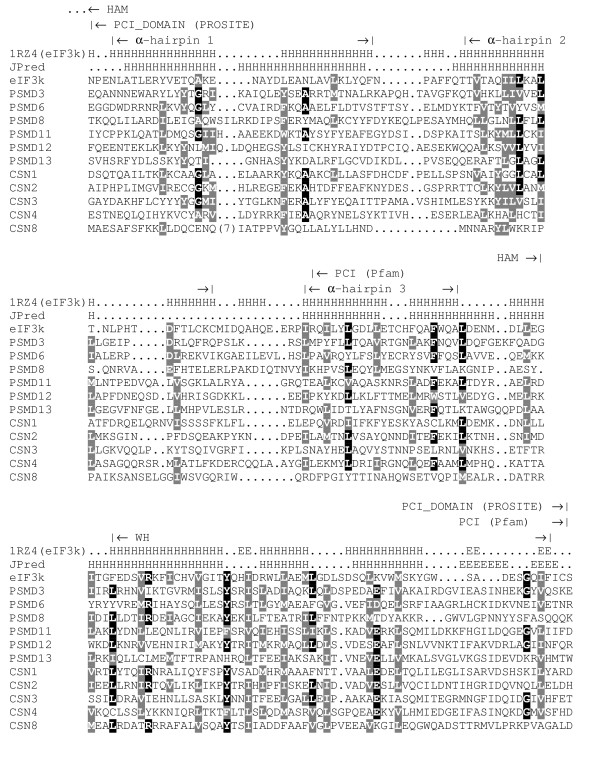
Multiple sequence alignment of human PCI subunits from proteasome lid, CSN and eIF3. Shown are only the segments matched by the PROSITE PCI domain. Conserved residues printed on black background were found in at last 50 % of ~60 PCI proteins from selected species, from which only human representatives are shown. Grey background was assigned to positions occupied by residues with similar physicochemical properties in at least 50 % of the sequences. The alignment was shaded using BOXSHADE . Above the PCI alignment secondary structure prediction as calculated from JPred [31] is presented. In these calculations sequences of eIF3k homologues were not included. Secondary structure elements of eIF3k as derived from PDB structure 1RZ4 are shown in a separate row. The abbreviations denote the following secondary structure types: E extended (sheet) and H helix. In addition, structural subdomain classification ('HAM', 'WH') as described in Wei et al. [26] and domain boundaries according to PCI profiles from PROSITE and Pfam are provided. Sequence names correspond to the following SwissProt database entries: eIF3k (Q9UBQ5), PSMD3 (O43242), PSMD6 (Q15008), PSMD8 (P48556), PSMD11 (O00231), PSMD12 (O00232), PSMD13 (Q9UNM6), CSN1 (Q13098), CSN2 (P61201), CSN3 (Q9UNS2), CSN4 (Q9BT78), CSN8 (Q99627).